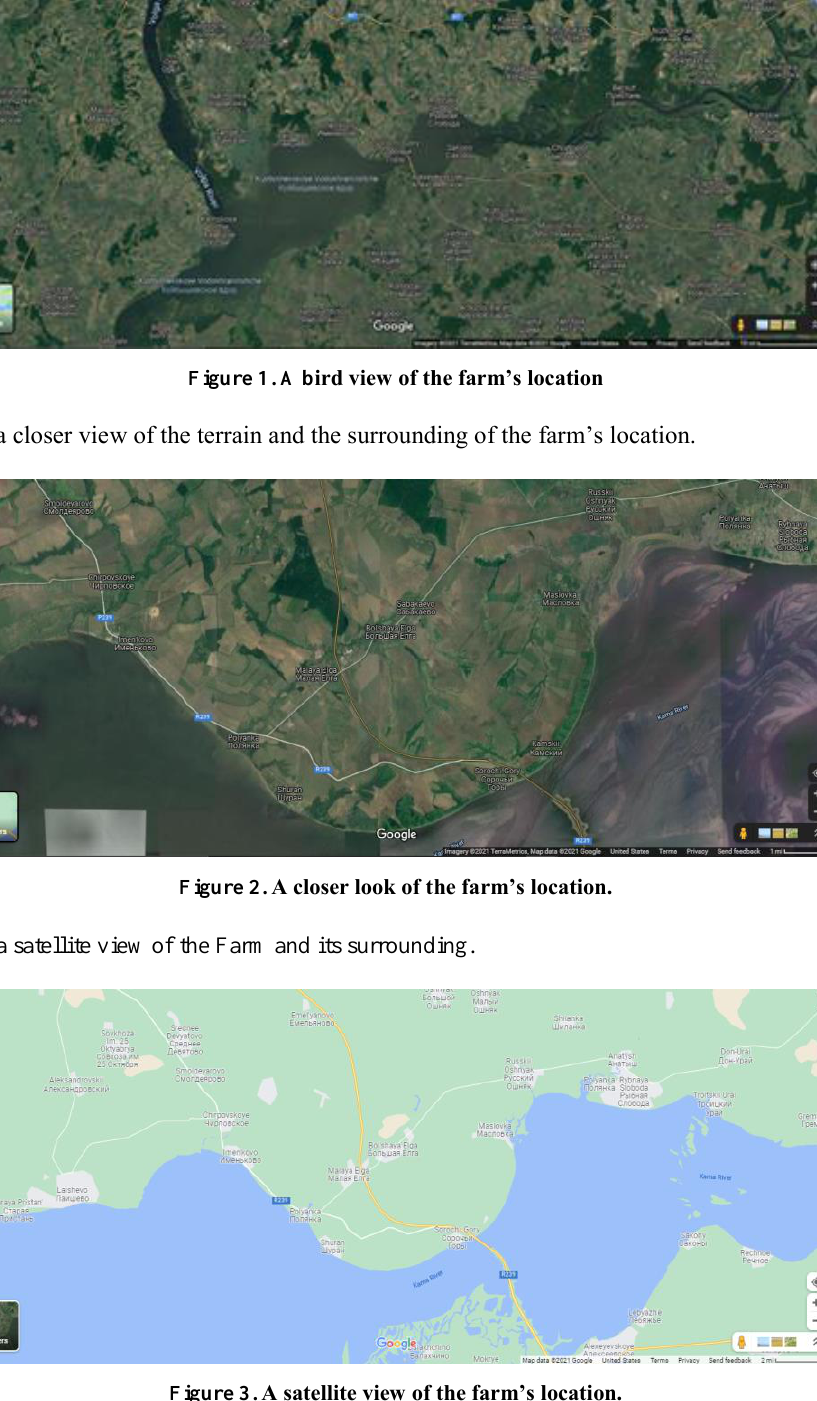
Figure 3. A satellite view of the farm’s